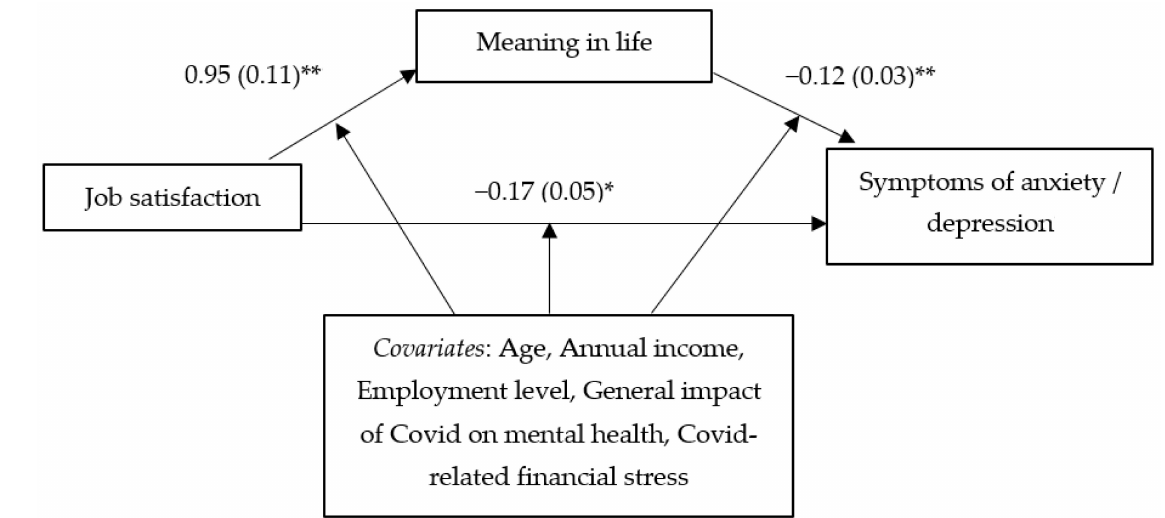
Figure 1. Mediation relationship between job satisfaction, meaning in life, and symptoms of anxi- ety/depression. * p < 0.01; ** p <